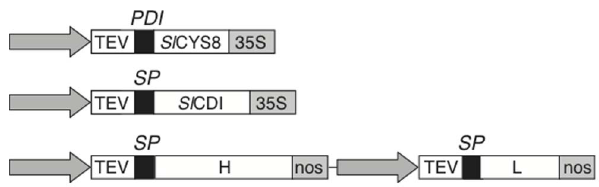
Figure 1. Binary vectors for C5-1, Sl CYS8 and Sl CDI expression. The constructs were devised for targeting the proteins to the apoplast. Each construct included a duplicated version of the CaMV 35S constitutive promoter (arrow), the TEV enhancer sequence (TEV), the respective protein-coding sequences ( Sl CYS8, Sl CDI, H and L for C5-1 heavy and light chains) and a CaMV 35S terminator (35S) or nopaline synthase terminator (nos) sequence. Constructs for Sl CYS8 secretion included the coding sequence of alfalfa protein disulphide isomerase signal peptide (PDI). Constructs for C5-1 and Sl CDI included the native signal peptide (SP) of these